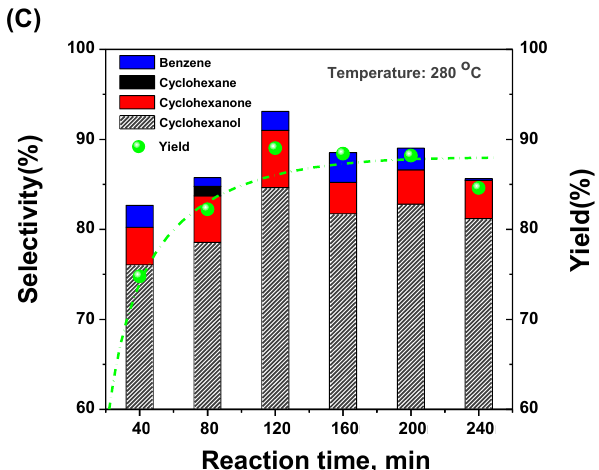
Figure 6. The kinetic behaviors of the selective conversion of phenol in subcritical water under different temperatures.